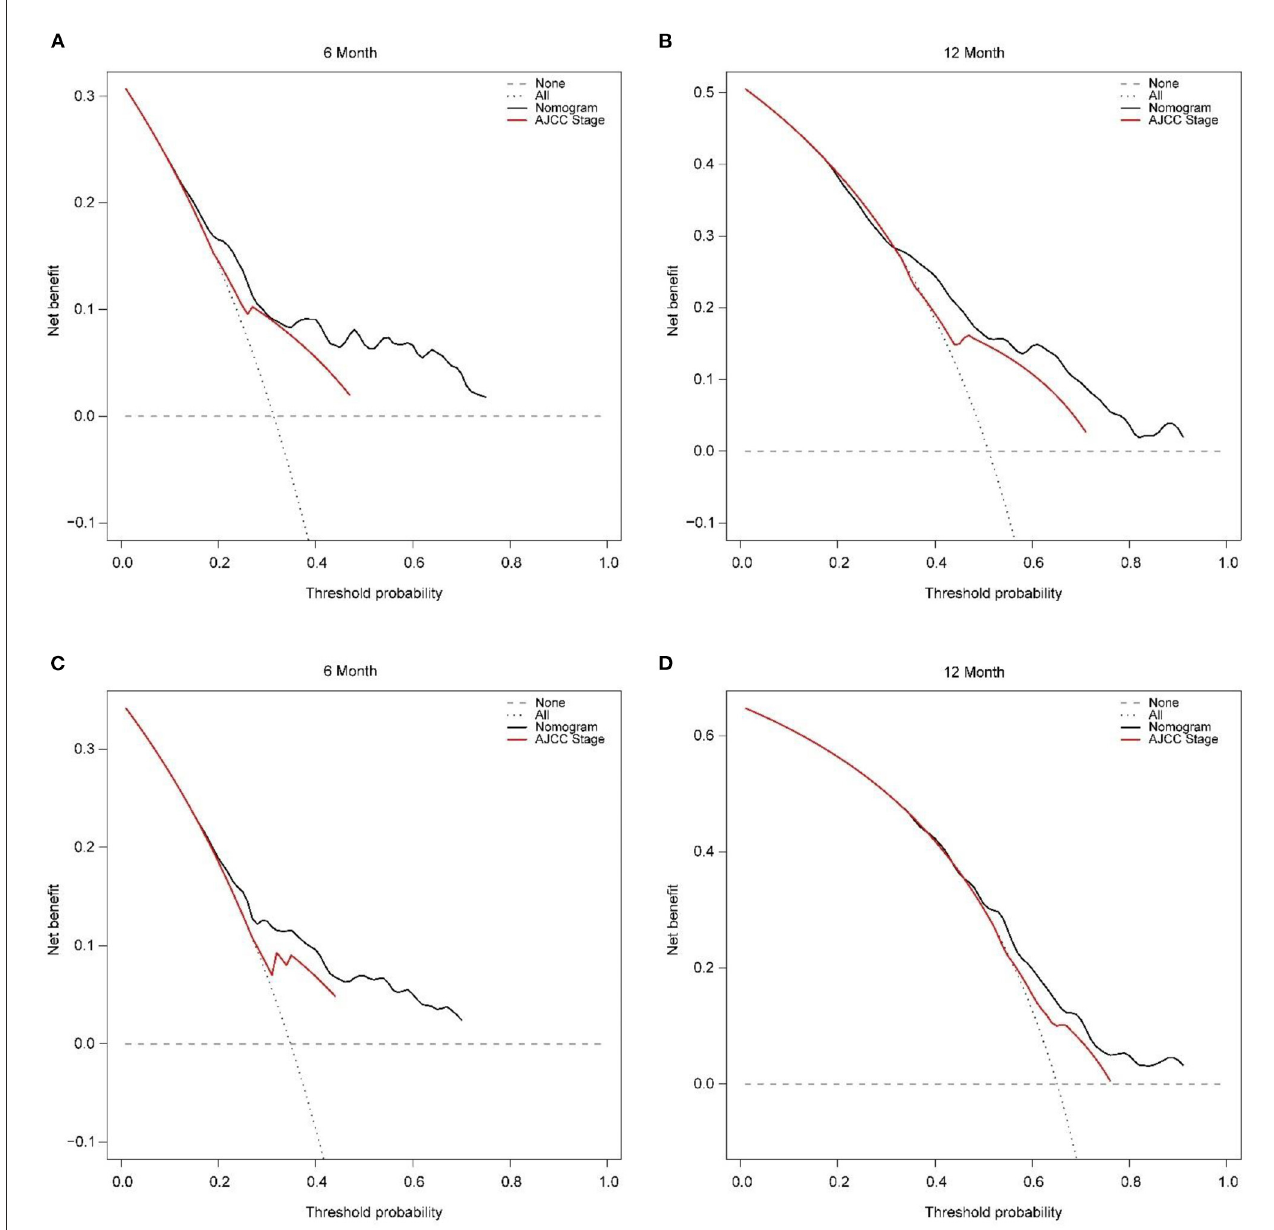
FIGURE6 Decision curve analysis of training set (A, B) and validation set (C, D) compare with the AJCC stage for predicting 6 months CSS and 12 months CSS. CSS, cancer-specific